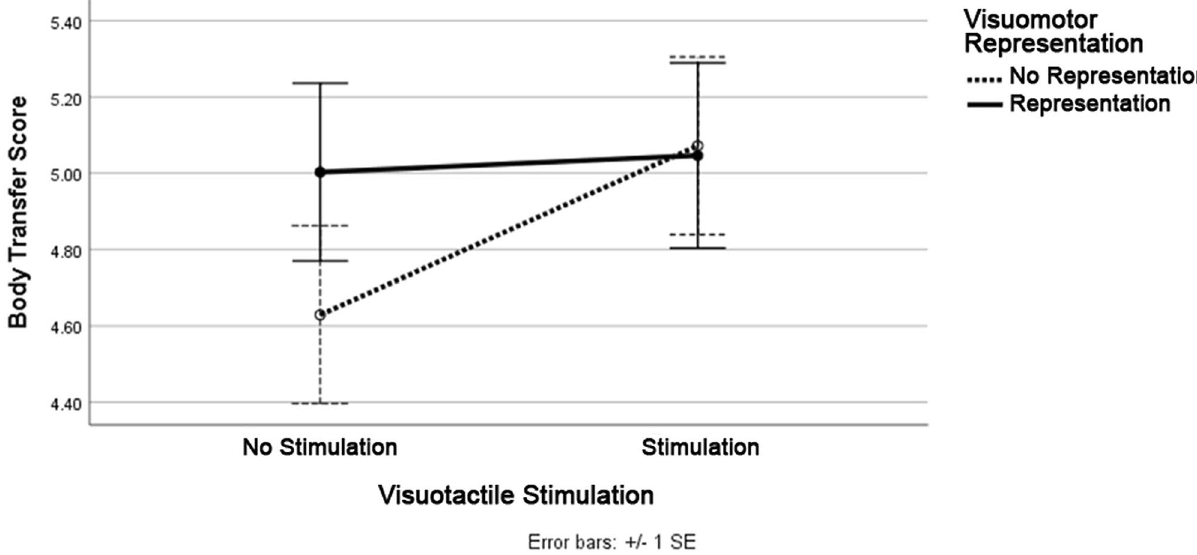
Figure 4. Body transfer scores across the four experimental conditions in Study 2.